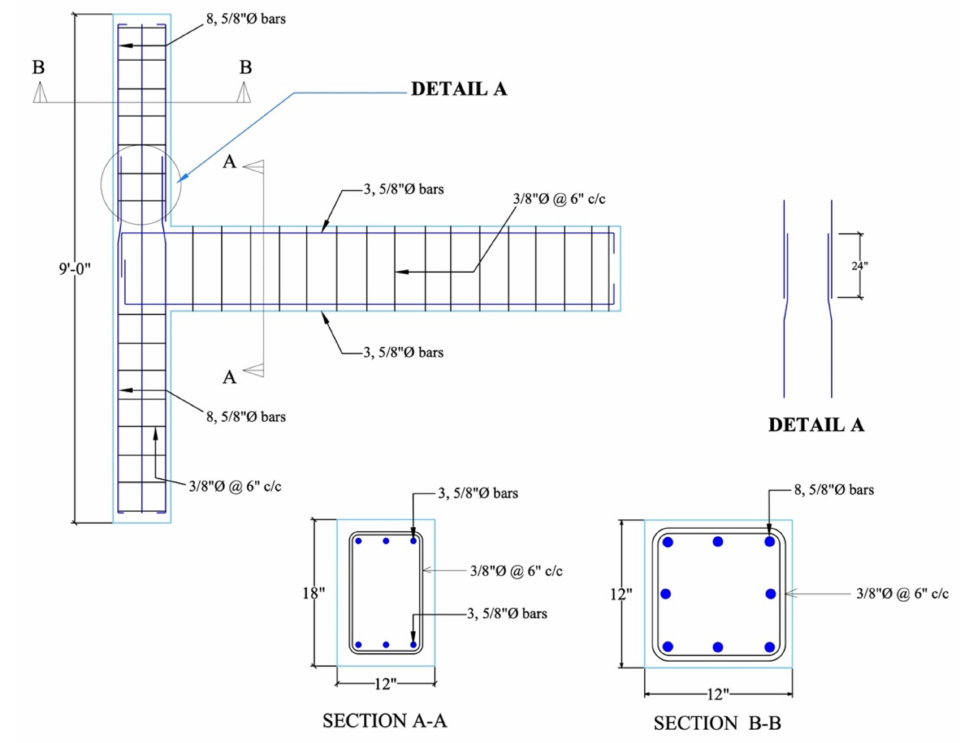
Figure 13. Geometric and reinforcement details of substandard beam–column